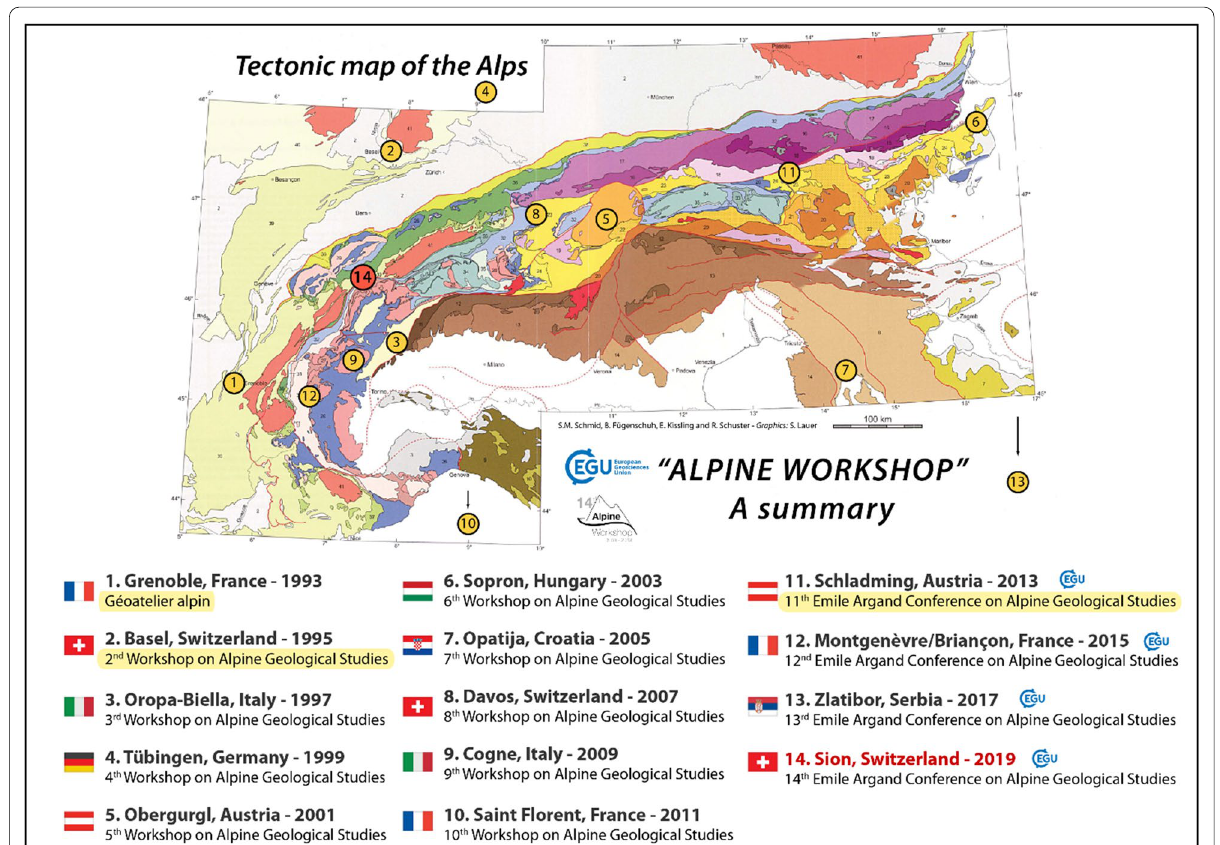
Fig. 1 Schematic tectonic map of the Alps with locations of previous Alpine Workshops indicated. The first Alpine Workshop was held in Grenoble, France back in